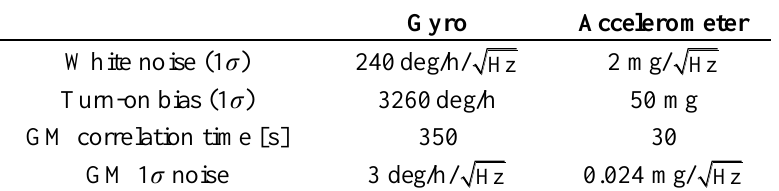
Table 5. Estimated error models of the MTi-G IMU for each